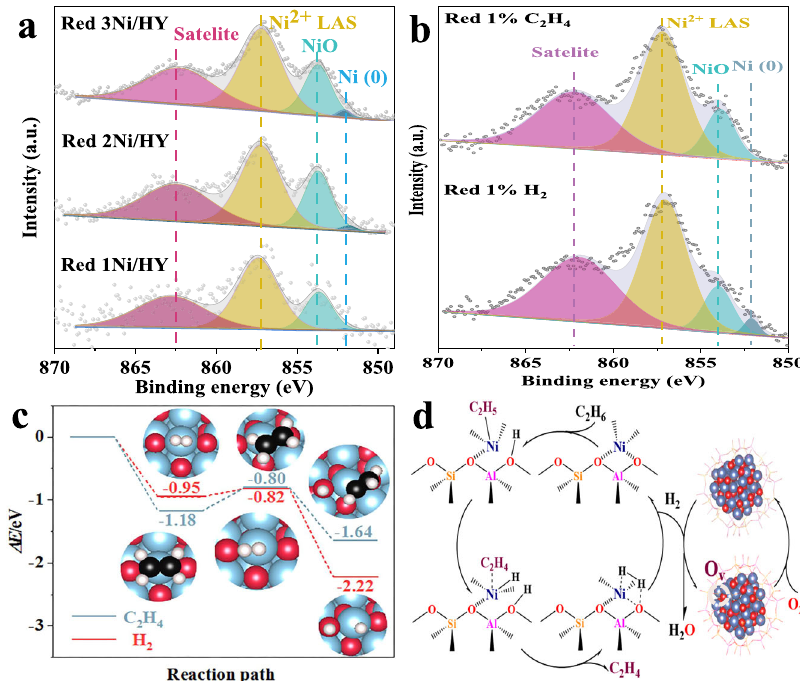
Fig. 4 Reaction mechanism. Ni 2p 3/2 XPS spectra of a reduced x Ni/HY samples in reaction condition, and b 1%H 2 and 1%C 2 H 4 reduced 3Ni/HY. c Potential energies pro fi les for C 2 H 4 and H 2 dissociation pathways on 1 nm NiO cluster. Color index: Ni, blue, O, red, C, black, H, white. d Reaction mechanism proposed for anaerobic ODHE over Ni-modi fi ed